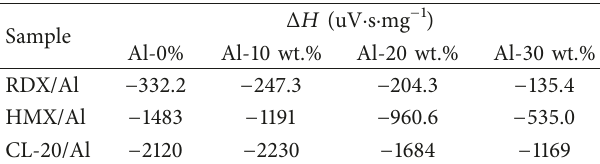
Table 3: Exothermic enthalpy data of the three groups of